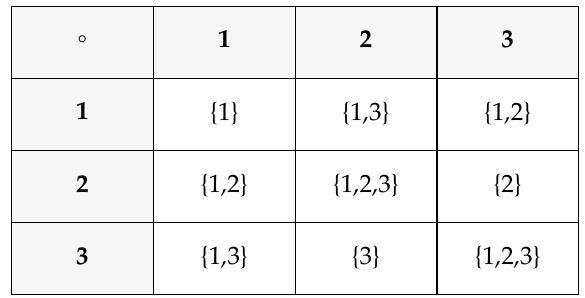
Table 6. Right almost-hypergroup.